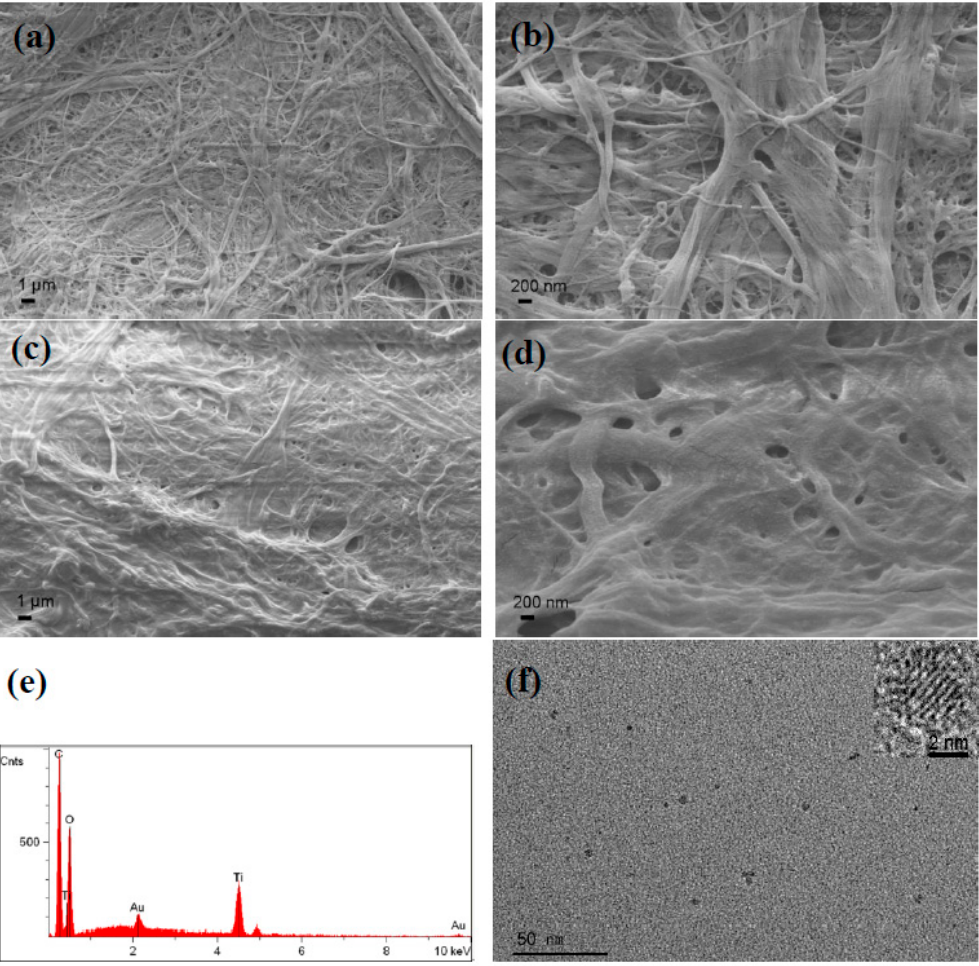
Figure 2. Scanning electron microscope (SEM) images of cellulose paper (substrate) at lower magnification ( a ) and higher magnification ( b ); the TiO 2 /cellulose composite film at lower magnification ( c ) and higher magnification ( d ); energy-dispersive spectroscopy (EDS) elemental analysis of TiO 2 /cellulose composite film ( e ); transmission electron microscope (TEM) of TiO 2 particles peeled off from TiO 2 /cellulose film by vigorous stirring, followed by sonication ( f ).